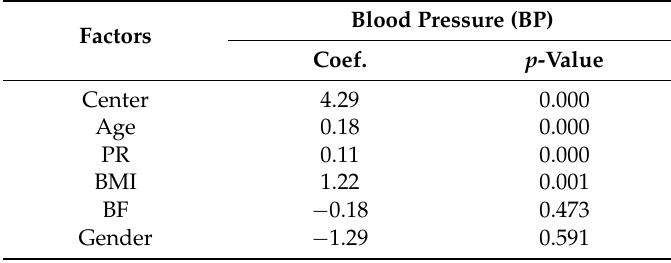
Table 4. Multiple regression analysis of blood pressure between two centers, controlling other variables.